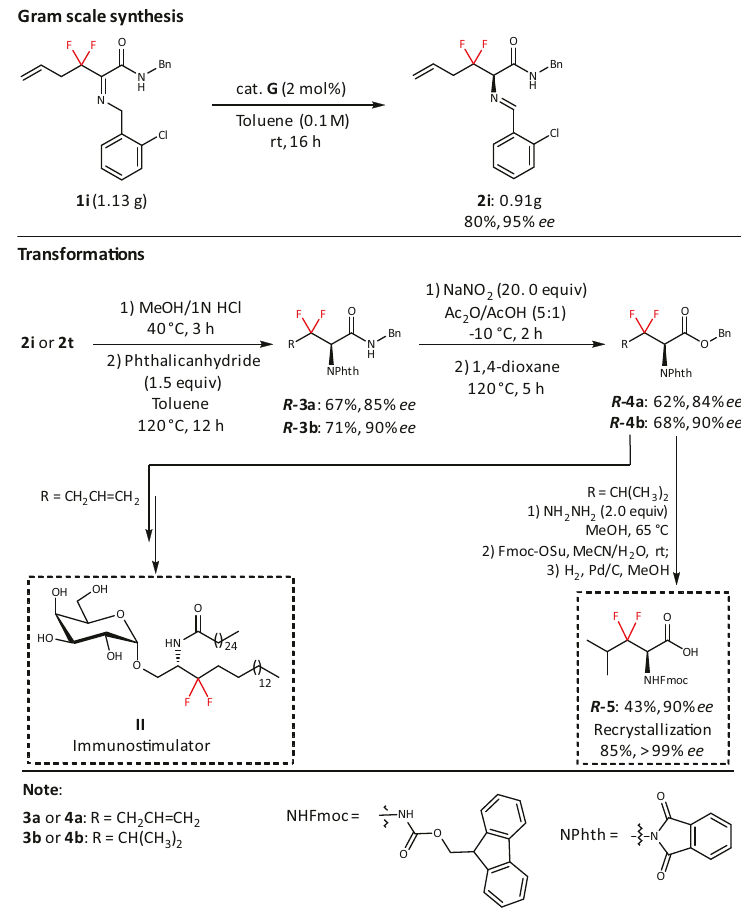
Fig. 7 Gram-scale synthesis and transformations. The gram-scale synthesis of 1i . The transformation of 2i to II and 2t to 5 .